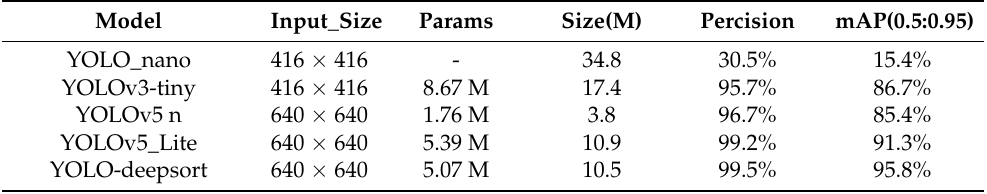
Table 5. The storage cost of YOLO-deepsort and other lightweight